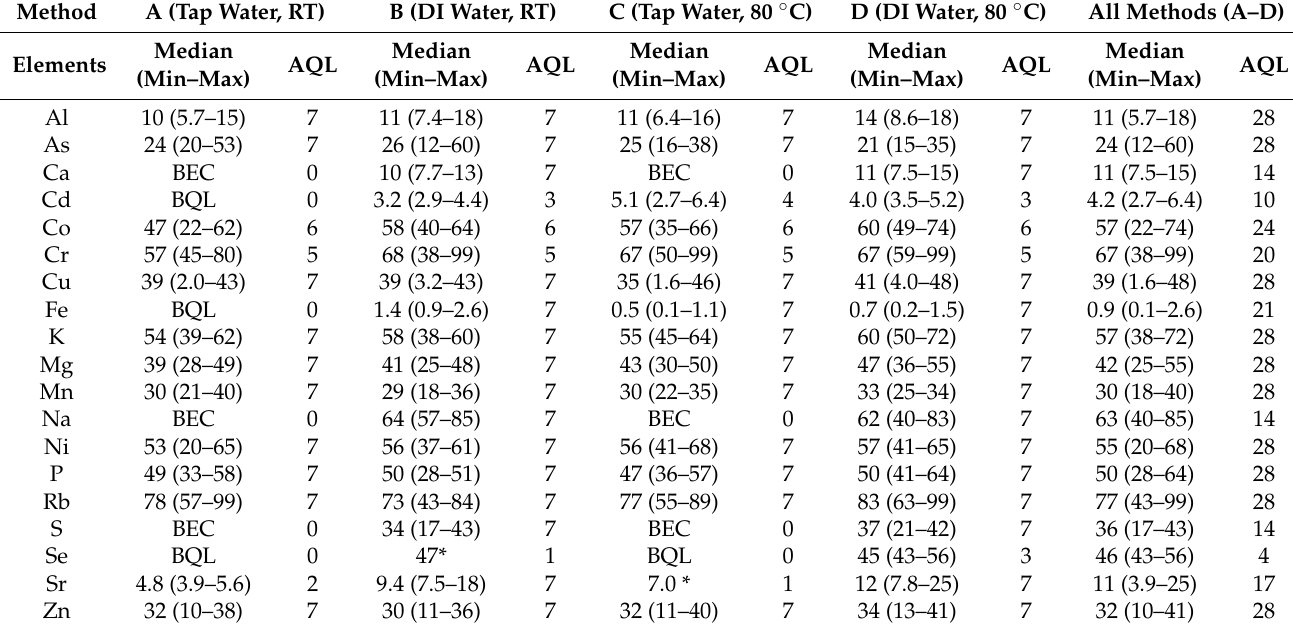
Table 3. Extraction percentage (% of total content) of selected elements in 7 samples of yerba mate (Ilex paraguariensis)